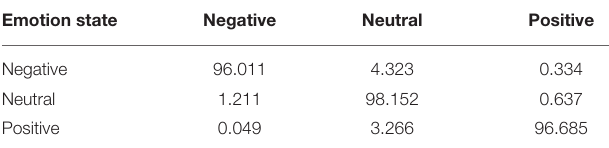
TABLE 6 | Dual-channel emotion recognition confusion matrix during healthcare lecture or electives in medical college.